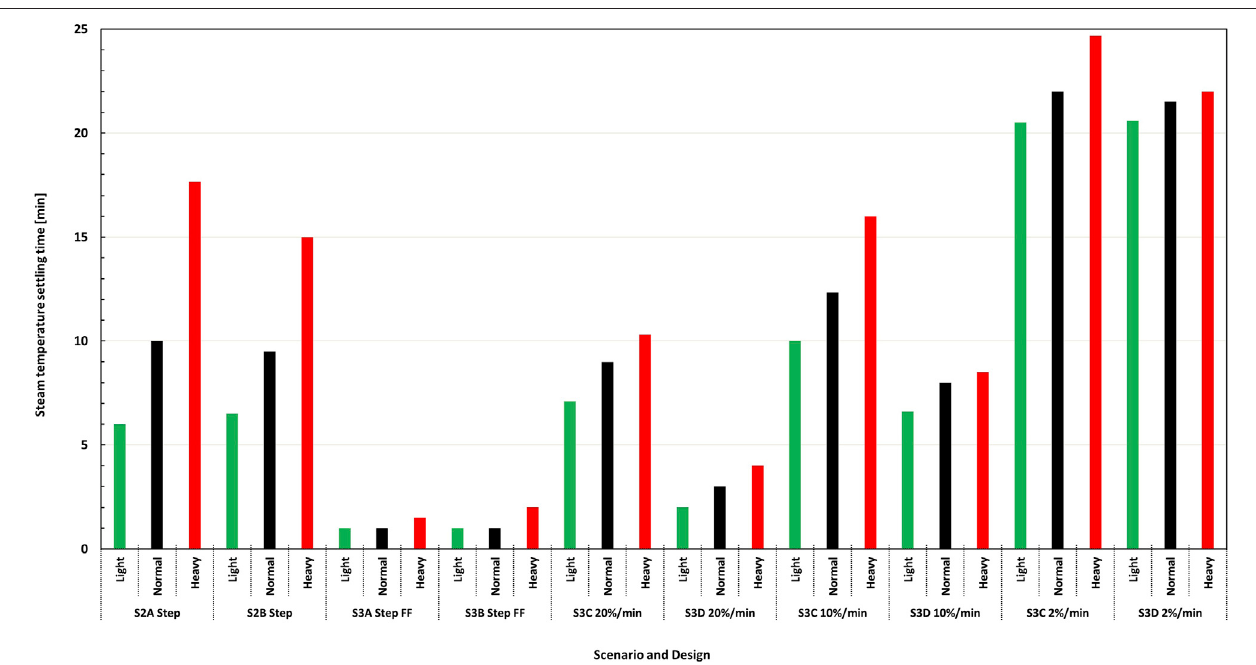
FIGURE11 | Steam outlet temperature settling times for Scenarios2and 3de fi ned in Table 4 , representingchangesin GT loadbetween 100%GT loadand 60% GT load. The results also include settling times for different OTSG designs (Light, Normal, and Heavy).